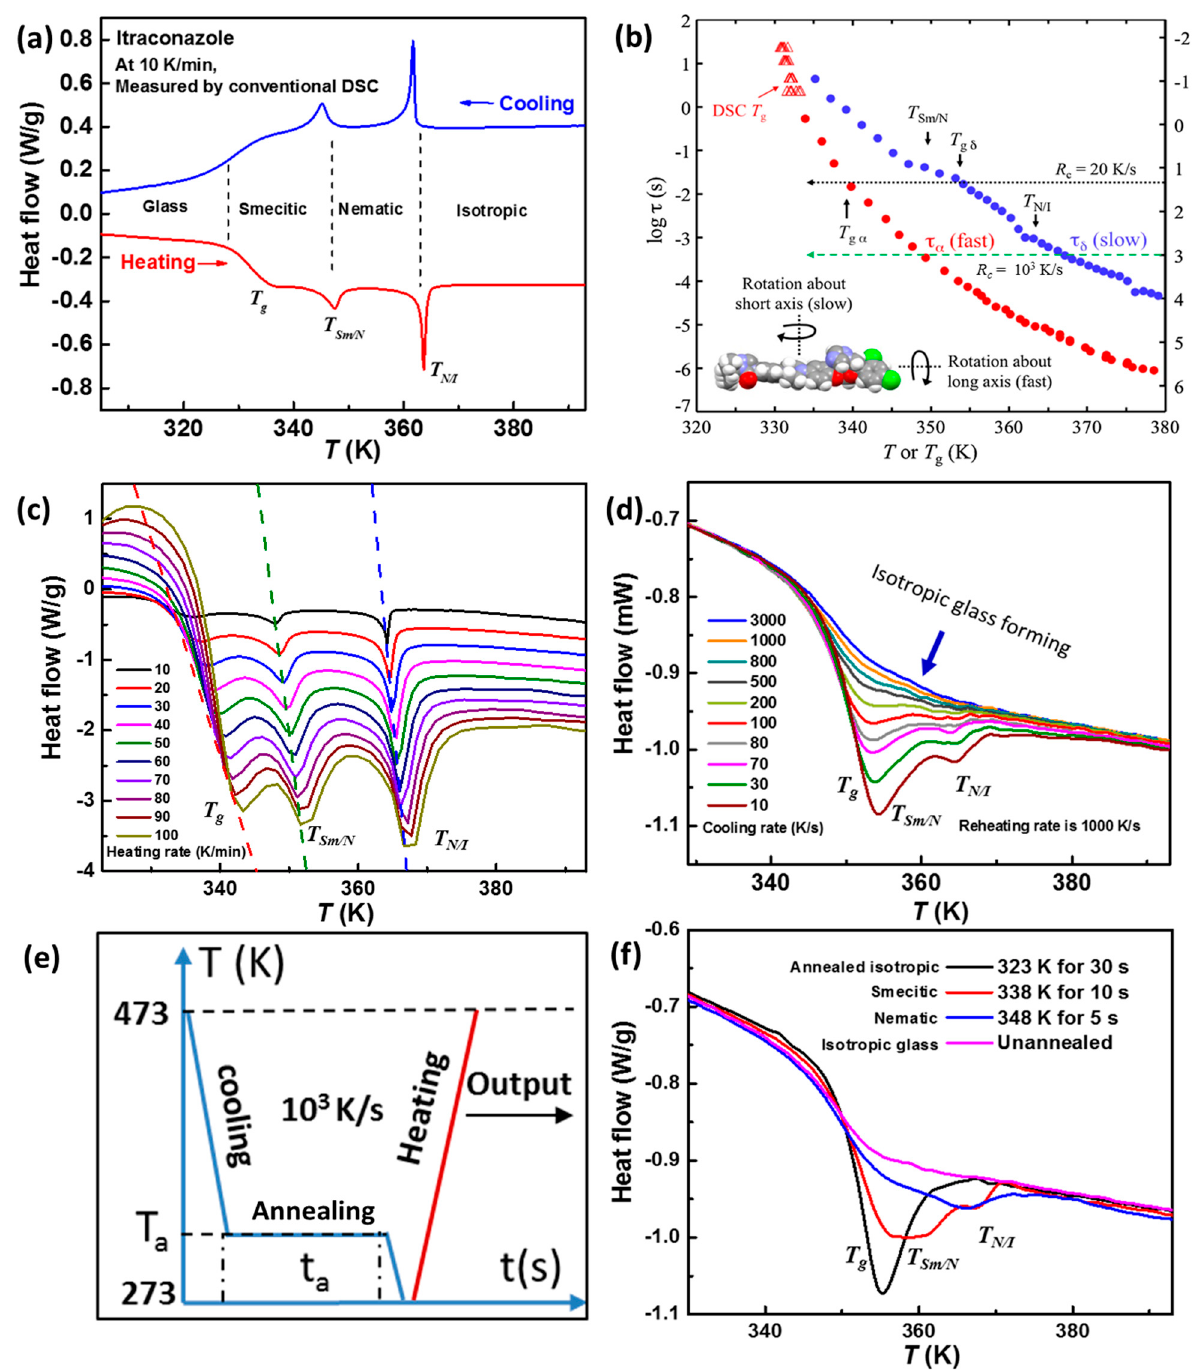
Figure 8. ( a ) Conventional DSC traces of ITZ during cooling and reheating at 10 K/min. ( b ) Fast (red circles) and slow (blue circles) relaxation processes in ITZ from dielectric spectroscopy from Ref. [34], and conventional DSC T g onset (triangle) is shown as a function of cooling rate R c (right axis) [5,34]. ( c ) A series of conventional DSC reheating traces with different heating rates, starting from the melt quenched ITZ glass at 10 K/min cooling rate. ( d ) Flash DSC reheating curves with 10 3 K/s heating rate, and the measured ITZ glass formed upon a series of cooling rates from 10 to 3 × 10 3 K/s. ( e ) The experimental protocol for the different ITZ glass formation in ( f ). ( f ) Flash DSC reheating curves at 10 3 K/s heating rate, to examine the ITZ glassy state after the different annealing conditions.